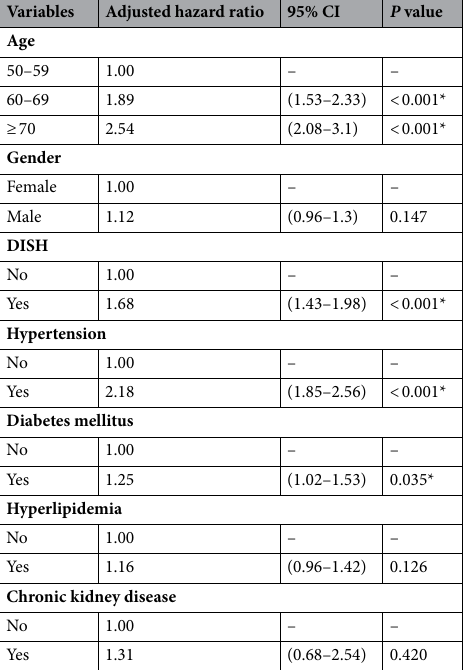
Table 2. Adjusted hazard ratio of stroke in patients based on age, gender, and comorbidities. DISH diffuse idiopathic skeletal hyperostosis, CI confidence interval. * p < 0.05.